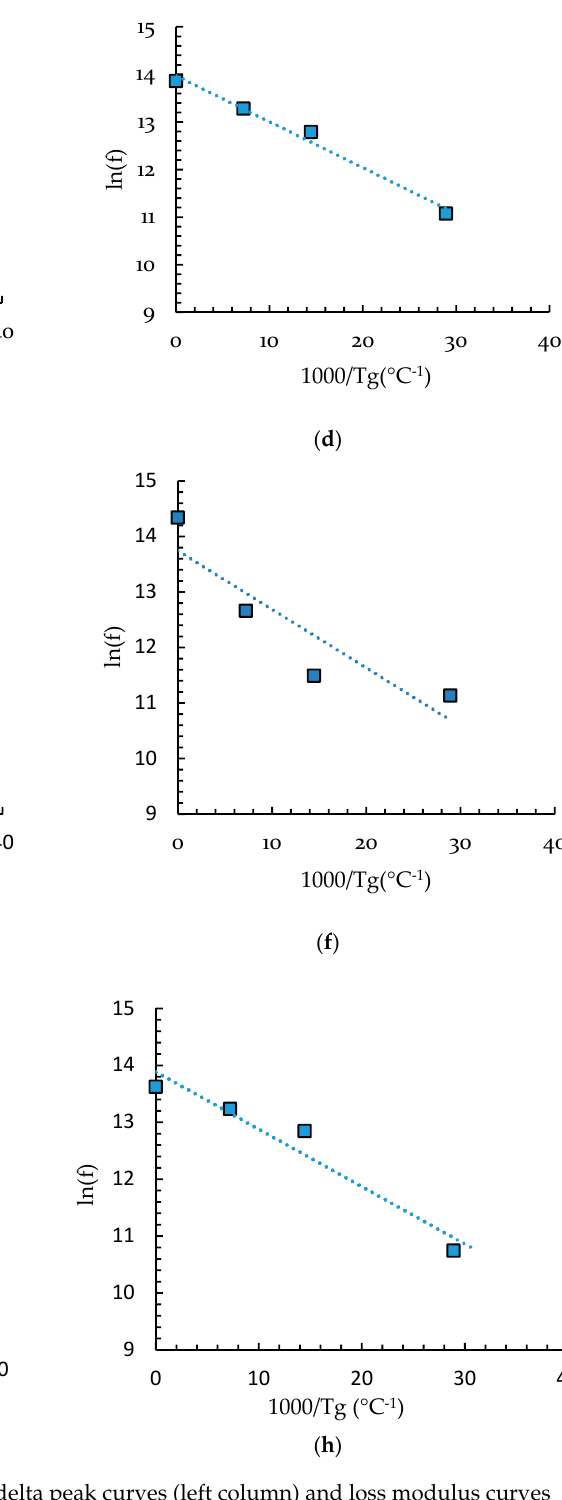
Figure 5. Variation of T g as measured by tan delta peak curves (left column) and loss modulus curves (right column) for the di ff erent composites’ configurations. ( a , b ) Just CF composite configuration. ( c , d ) CF and ZnO composite configuration. ( e , f ) CF and CNTs composite configuration. ( g , h ) The CNT and ZnO composite configuration.